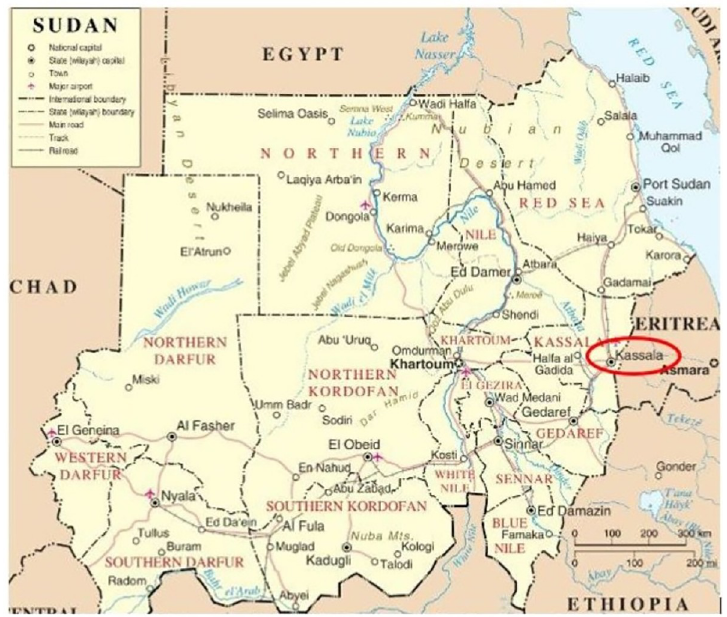
Fig 1. Study location: Kassala state , located in Eastern Sudan , 600 km the capital city , Khartoum . covers an area of 42,282 km 2 and has a population 1.8 million inhabitants. Kassala City is the State capital with a population of ~ 400,000. Kassala Teaching Hospital is the State tertiary hospital and provides service for all patients referred from health centres and rural hospitals. The source of the map is: https://commons.wikimedia.org/w/index.php?curid=